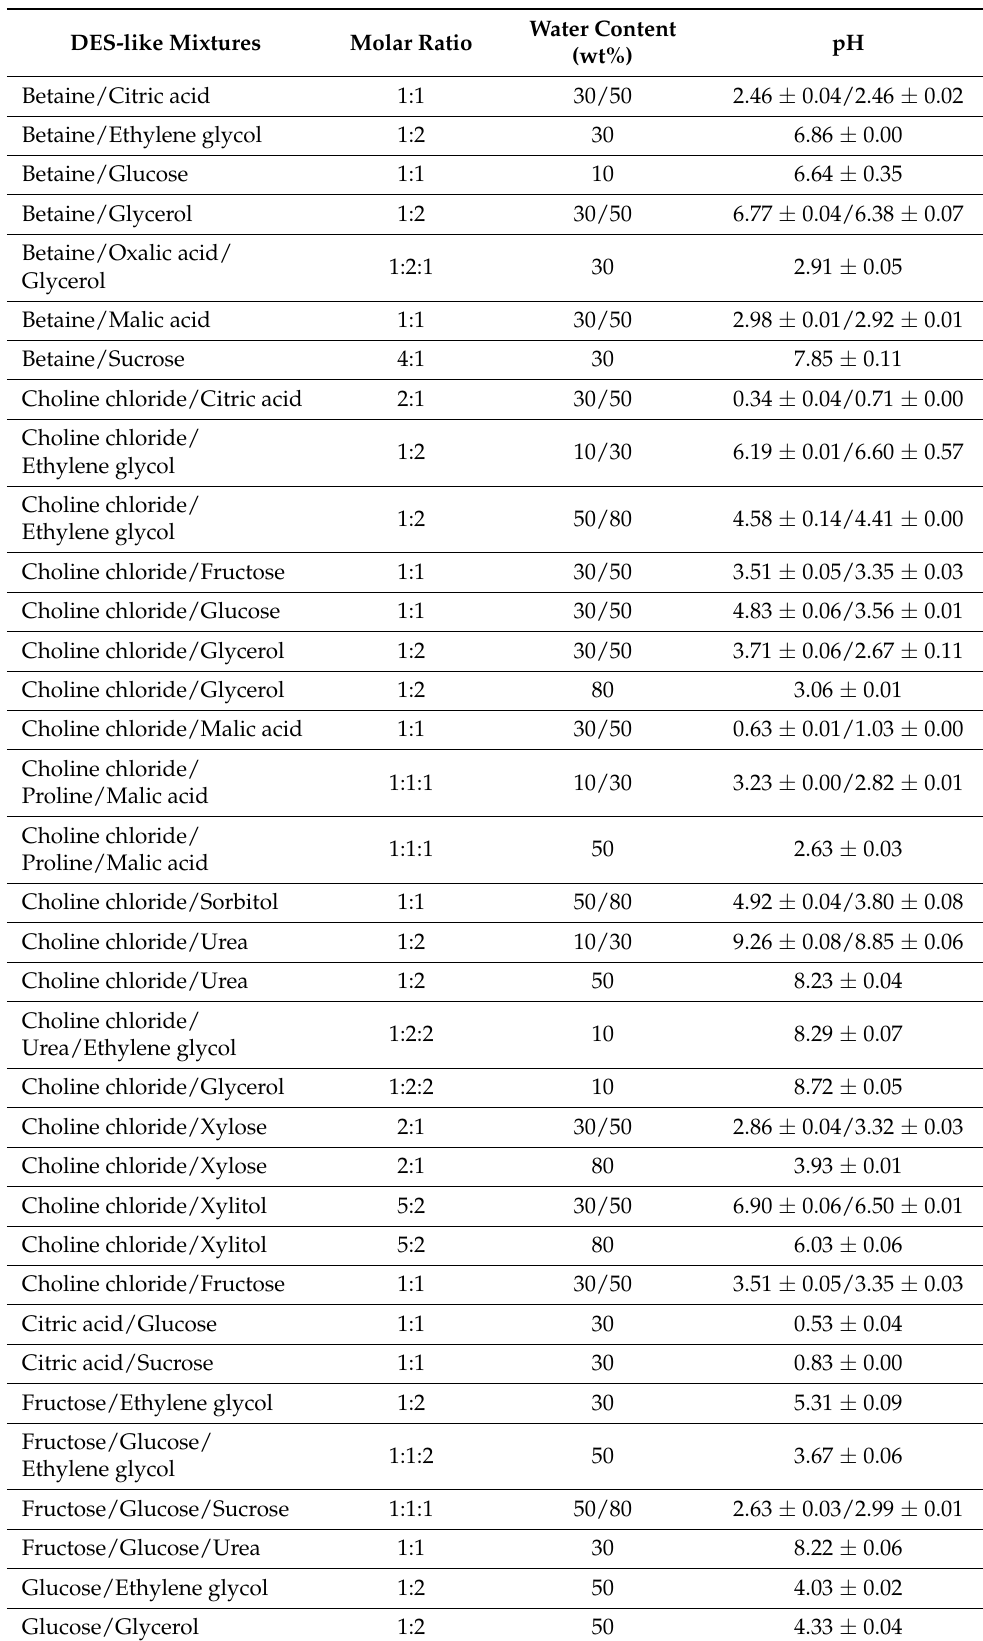
Table 14. The pH values of DES-like mixtures measured experimentally (adapted according to Pani´c et al.)